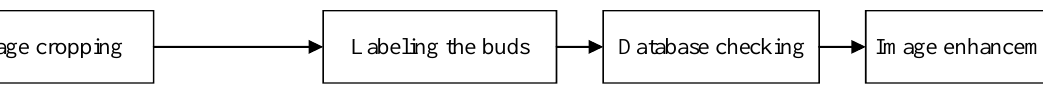
Figure 3. Flowchart of image processing steps.